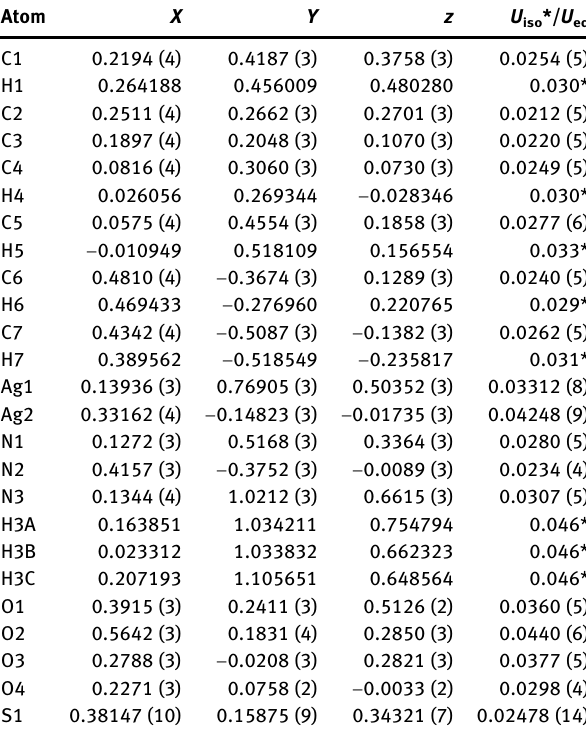
isotropic displacement parameters (Å 